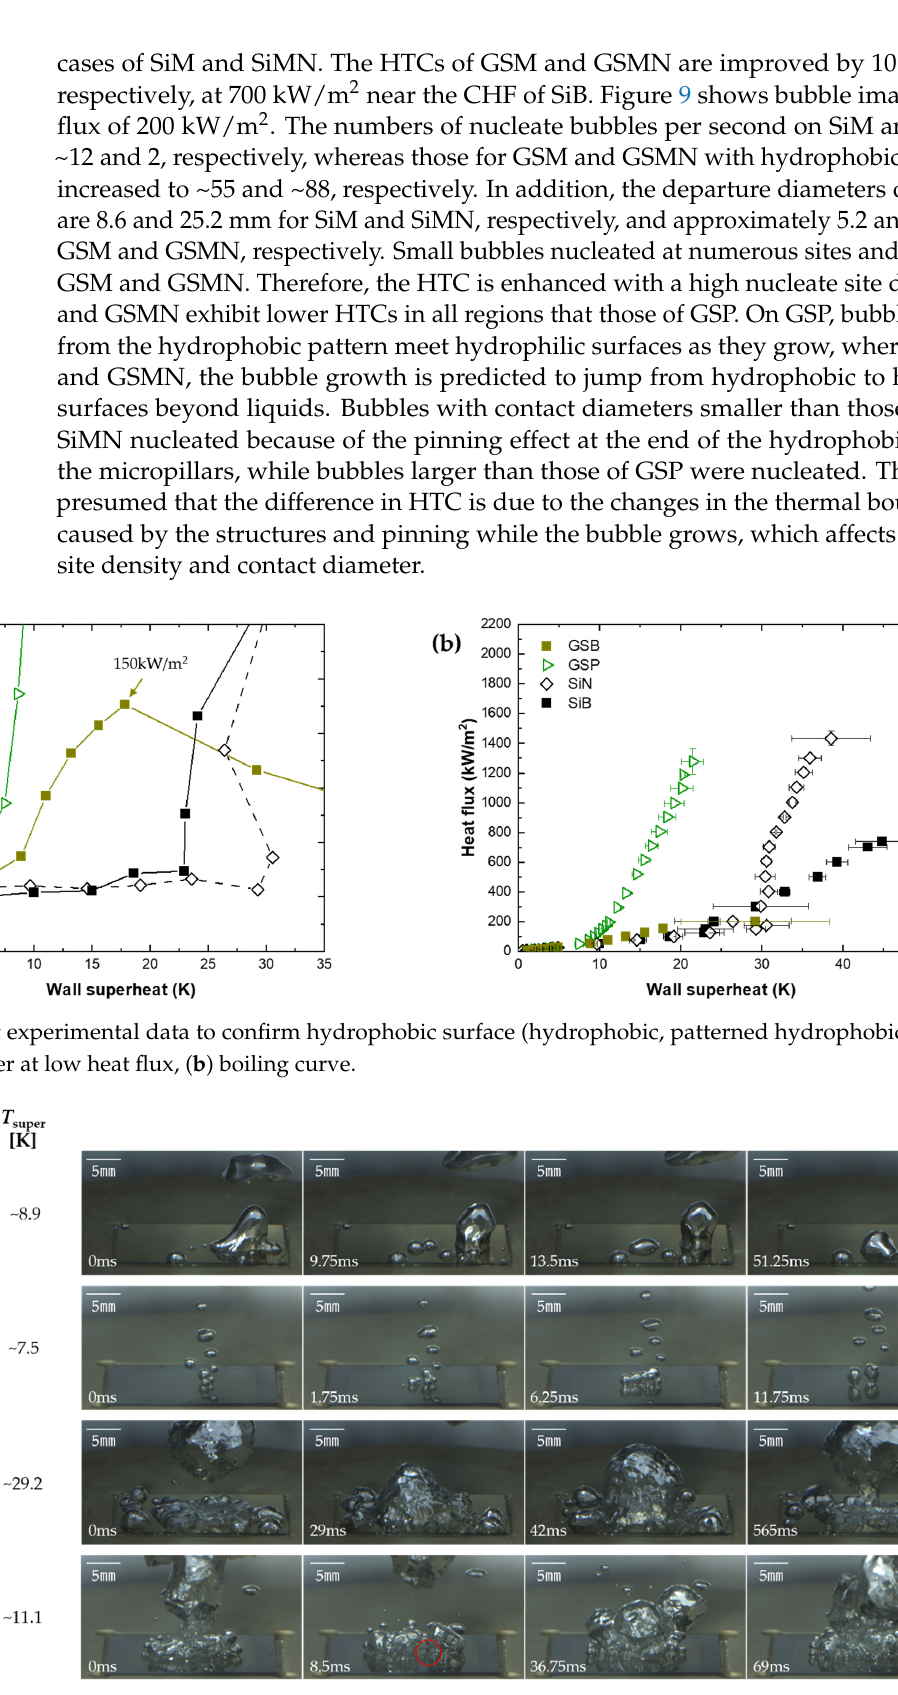
Figure 7. Bubble images on the GSB, GSP. GSB has large contact diameter bubbles and early CHF. GSP has smaller contact diameter than GSB due to pinning effect, and can maintain low wall superheat at high heat flux.